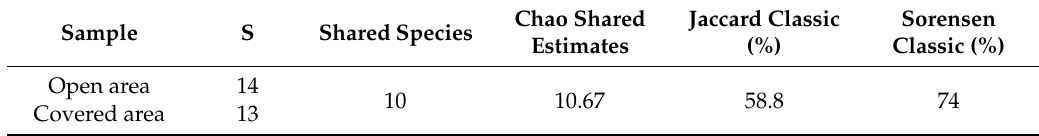
Table 11. Shared termite species between the two habitats (S = total observed species for each